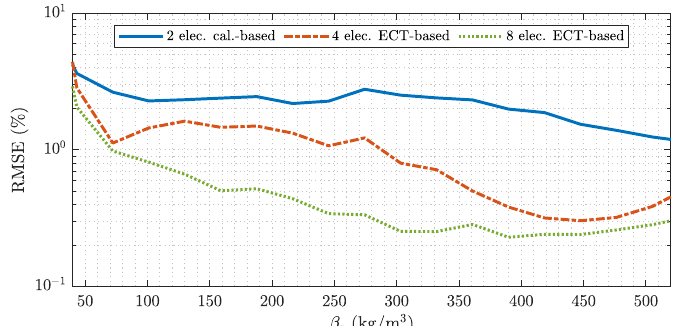
Figure 12. Model based analysis of the RMSE for sensor with different number of electrodes. The analyses are performed over all flow regimes covered by the stochastic process